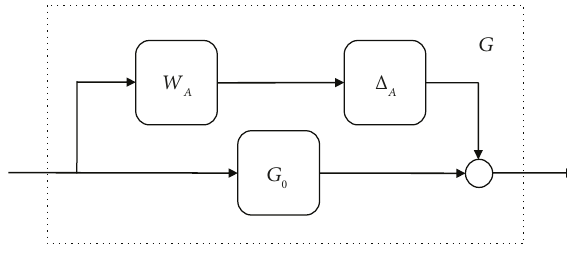
Figure 3: Plant with additive